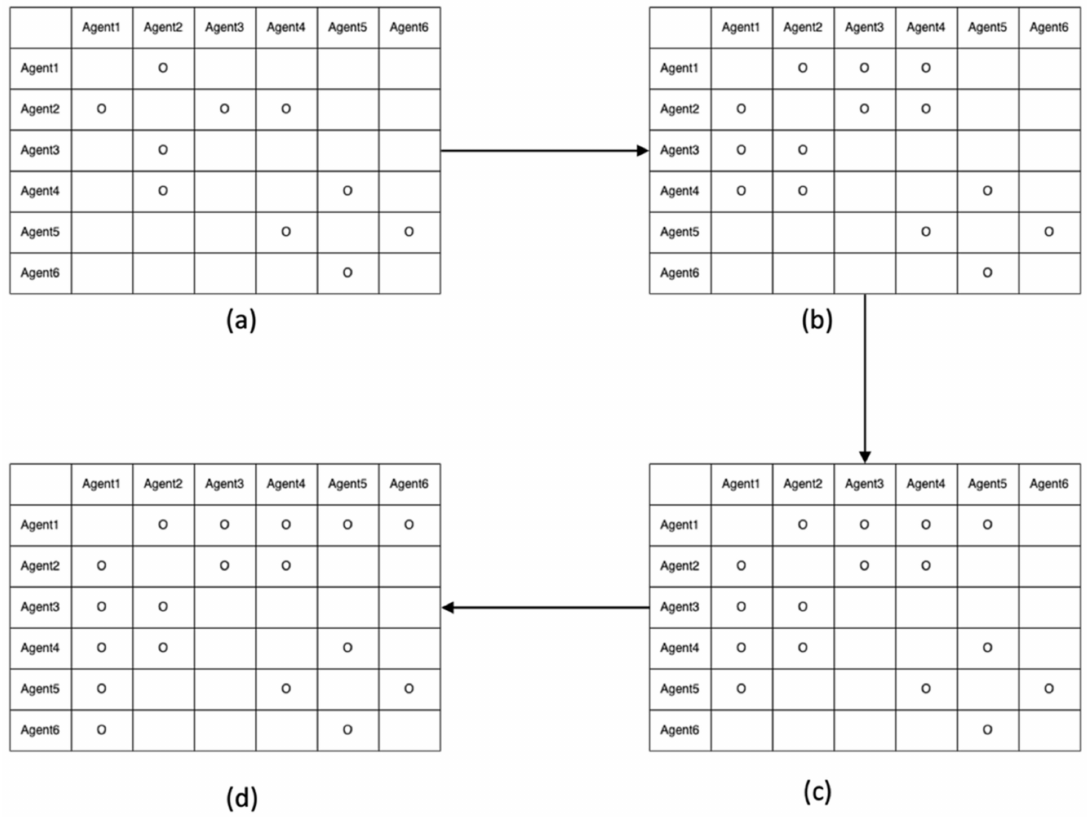
Figure 8. ART processes while implementing the proposed pseudocode. ( a ) Initial ART with resolved integer ambiguities in Figure 5. ( b ) Modified ART by updating N 13 and N 14 . ( c ) Further modified ART by updating N 15 . ( d ) Further modified ART by updating N 16